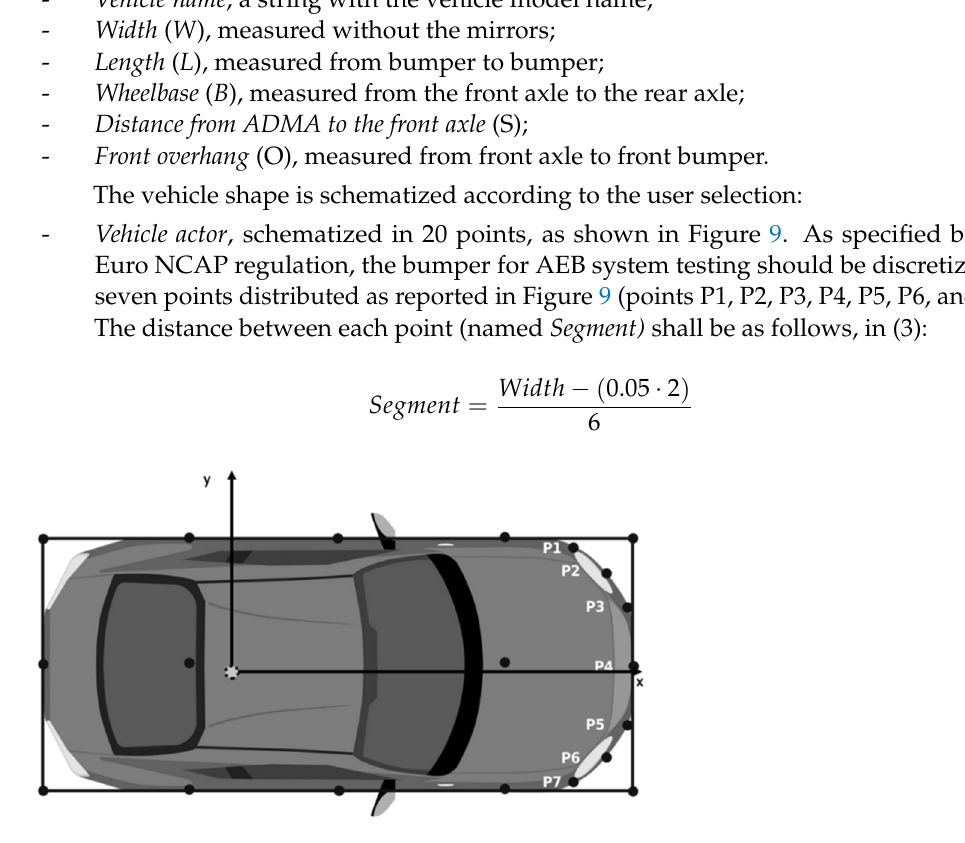
Figure 10. SPT schematization.